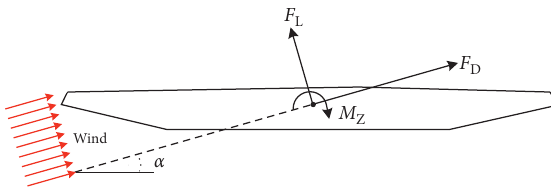
Figure 5: Aerostatic forces acting on the girder per unit span